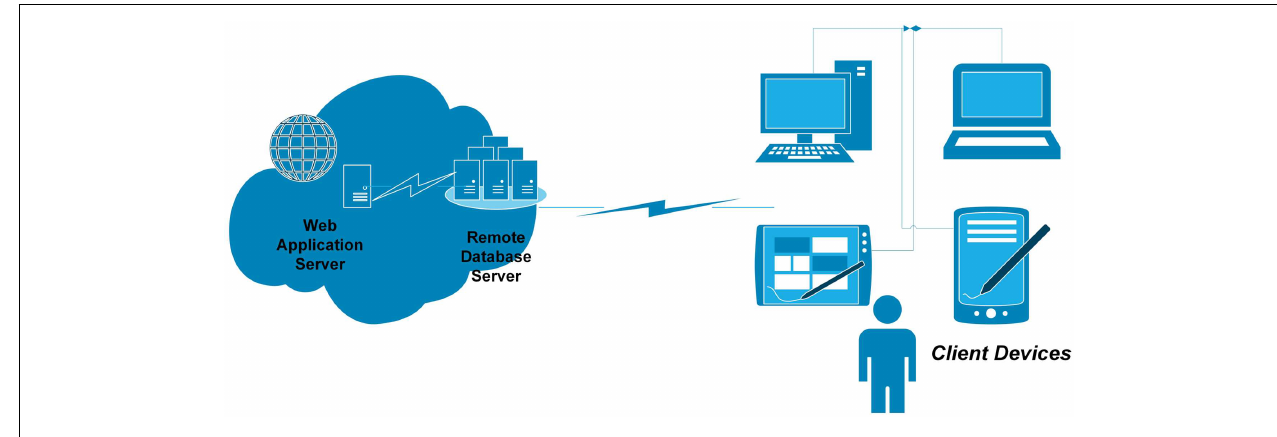
FIGURE 5 | ProposedATLAS data storage arrangements